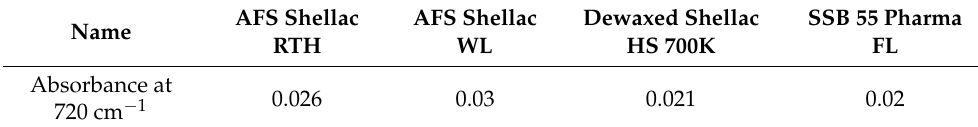
Figure 1. FTIR spectrum of different types of shellac. Table 2. Shellac material used in this